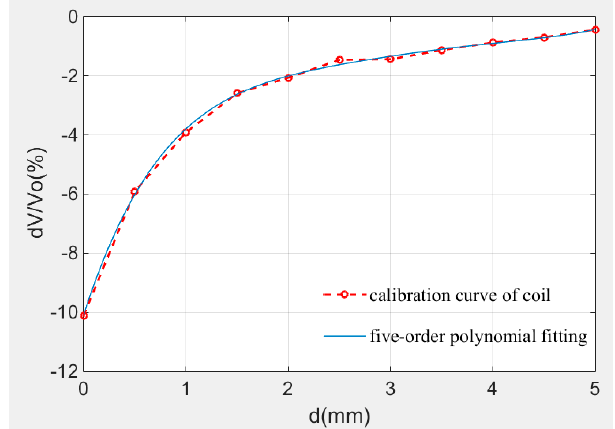
Figure 7. Calibration curve at room temperature. Table 1. Calibration data at near full range area.